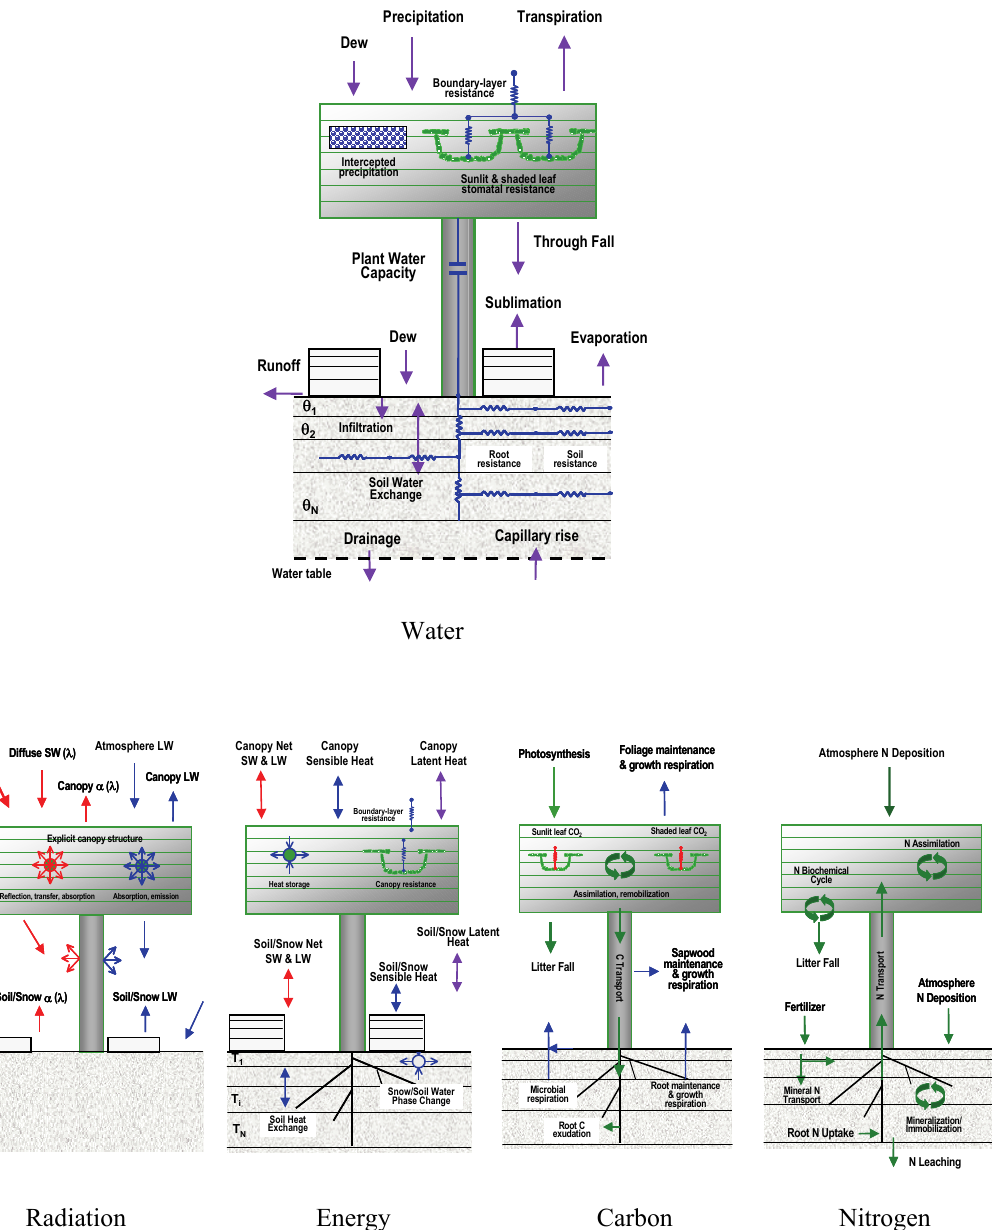
Fig. 1. The EALCO model diagram showing the land surface water (top) and radiation, energy, carbon and nitrogen (bottom) processes simulated in the